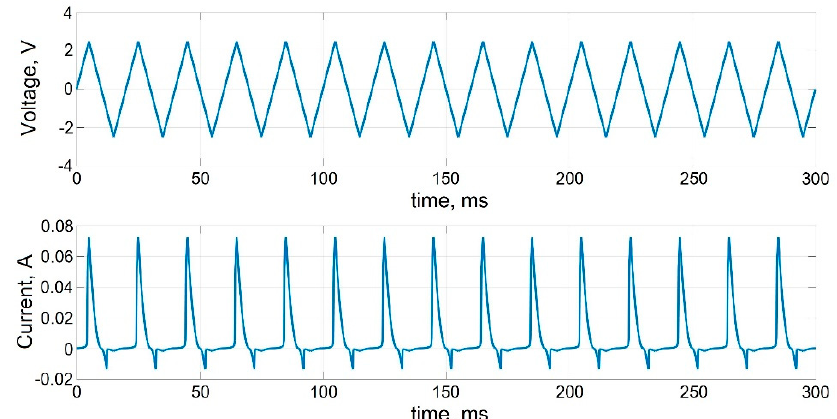
Figure 5. Transients of cyclic bipolar switching of memristive element.